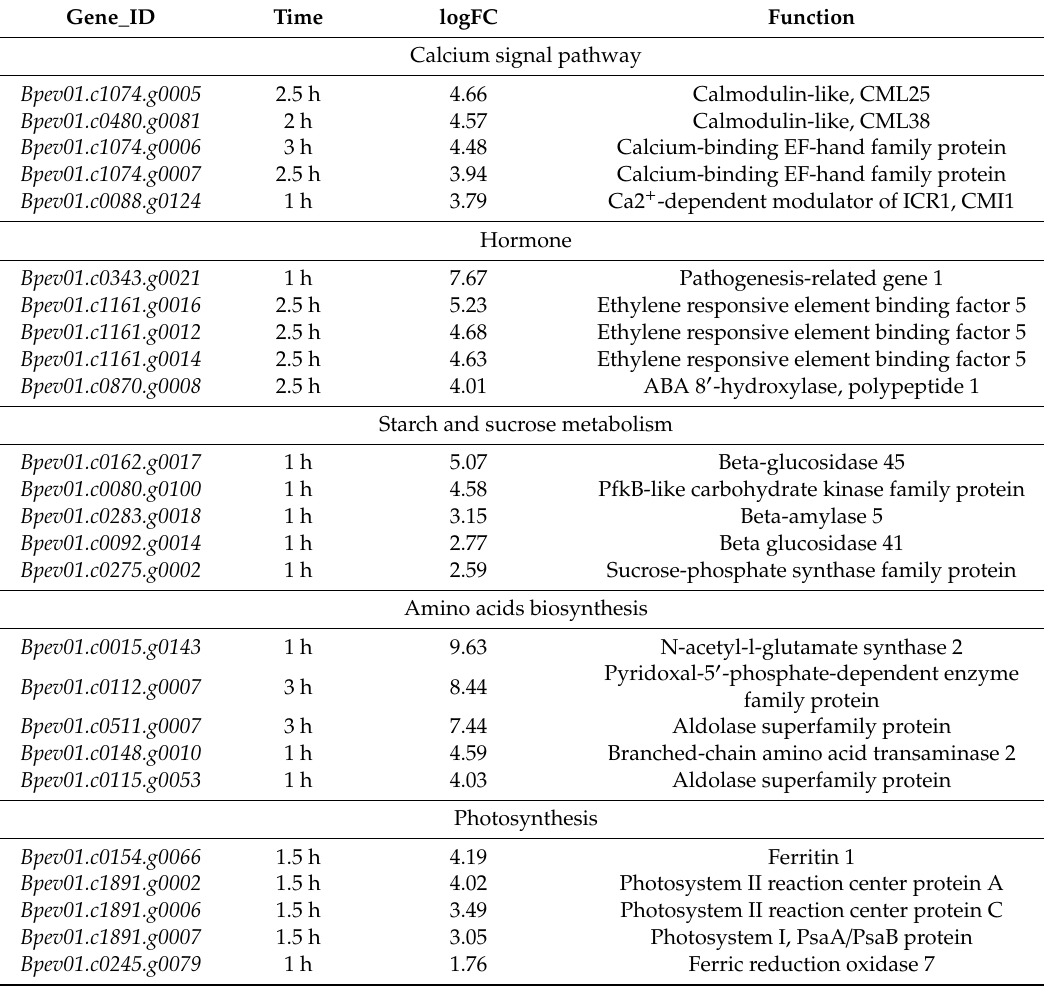
Table 3. Thirty significantly up-regulated DEGs of birch under low-temperature